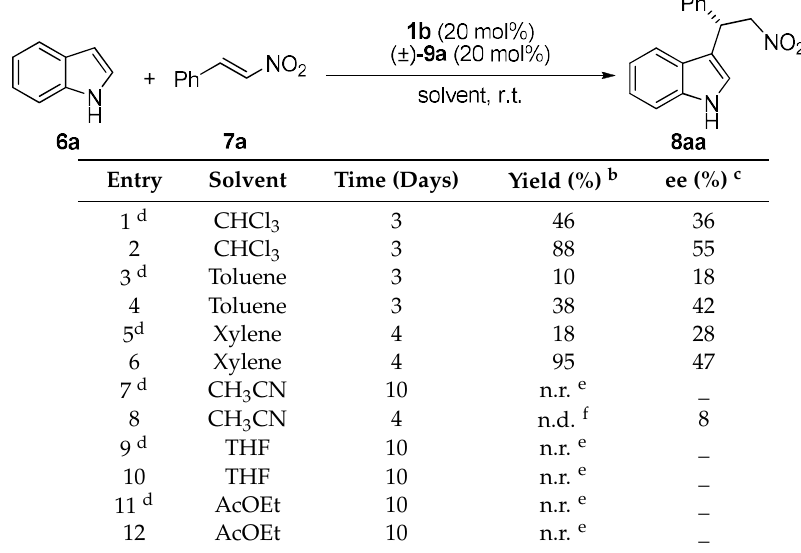
Table 1. Screening of catalytic complex 1b · ( ± )- 9a in different solvents. a.